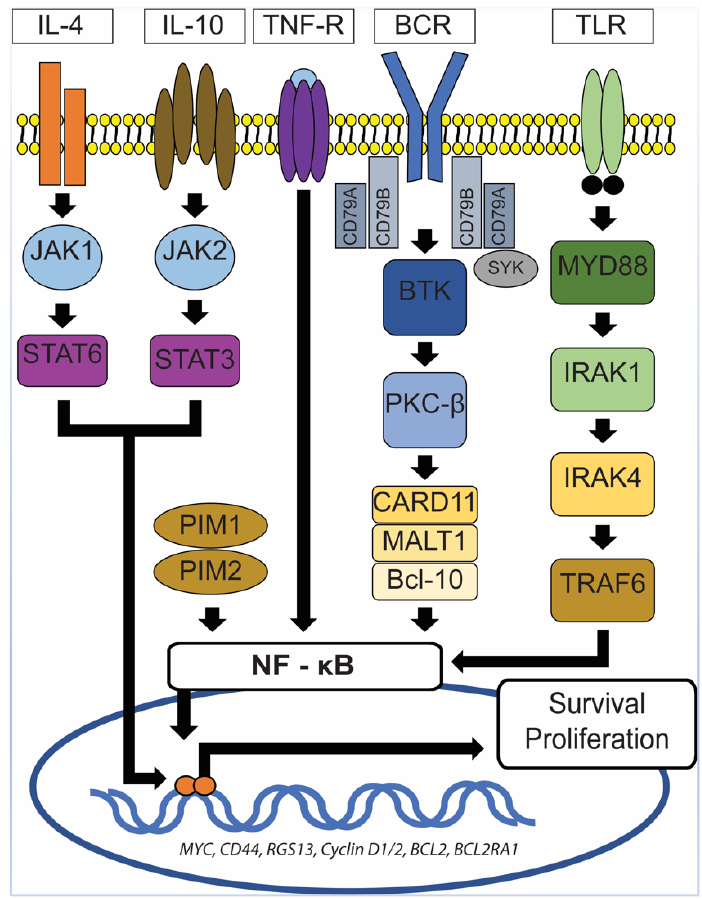
Figure 5. NF-kB signaling pathway. In PCNSL, activation of NF-kB signaling pathway can be mediated through the gain of 18q21.33-q23, activating the mutation of CARD11 and stimulation of the B-cell receptor (BCR), tumor necrosis factor (TNF), or toll-like receptor (TLR) pathway. MYD88 mutations, which are frequently seen in PCNSL, lead to spontaneous assembly of a protein complex containing IRAK1 and IRAK4, ultimately resulting in NF-kB signaling pathway activation, Janus kinase (JAK) activation of STAT3 pathway, and the secretion of IL-6, IL-10, and interferon- β . TNF-R: TNF receptor, MYD88: Myeloid di ff erentiation primary response gene 88, CARD11: Caspase recruitment domain family member 11, IRAK1 / 4: Interleukin 1 receptor-associated kinase 1 / 4, TRAF6: Tumor necrosis factor receptor (TNFR)-associated factor 6, BCR: B-cell receptor, SyK: Spleen tyrosine kinase, BTK: Bruton’s tyrosine kinase, PKC- β : Protein kinase C β type, MALT1: Mucosa-associated lymphoid tissue lymphoma 1, Bcl-10: B-cell lymphoma / leukemia 10, JAK1 / 2: Janus kinase 1 / 2, STAT3 / 6: Signal transducer and activator of transcription 3 / 6, IL-4 / 10: Interleukin 4 /